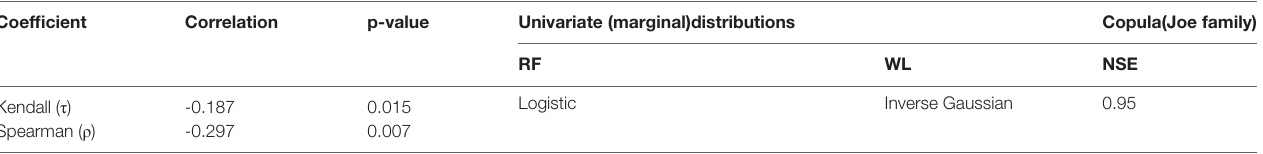
TABLE 2 | Correlation structure of flood drivers in Mobile Bay,